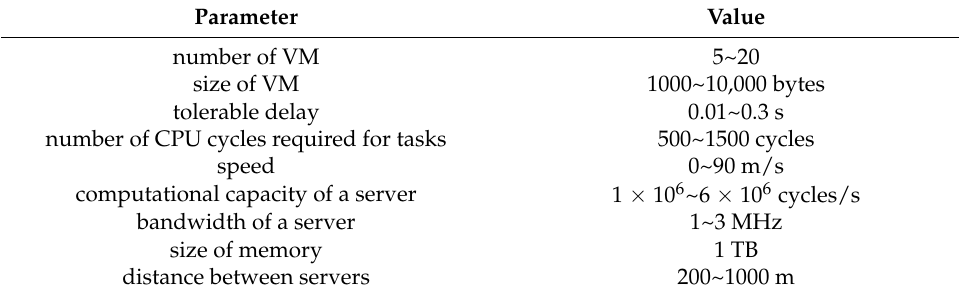
Table 1. Simulation experiment